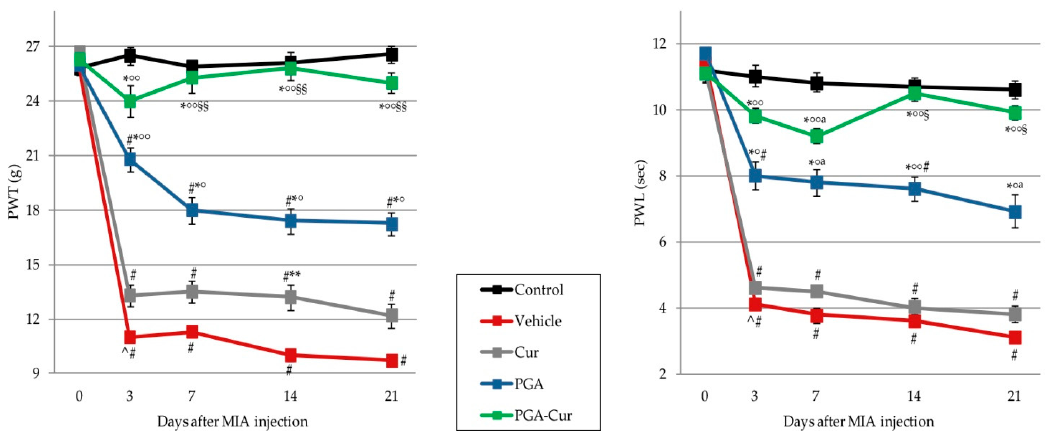
Figure 3. Effect of PGA and curcumin (Cur) given individually or in a co-micronized formulation (PGA-Cur) on monoiodoacetate-induced neuropathic pain. The effect was assessed on secondary allodynia by measuring paw withdrawal threshold (PTW) and paw withdrawal latency (PWL) before and after 3, 7, 14, and 21 days from MIA knee injection. Data are expressed as mean ± standard error of the mean (N = 10/group). PGA = micronized palmitoyl-glucosamine. ^ p < 0.0001 vs. previous time point; # p < 0.0001 and a p < 0.05 vs. control; * p < 0.0001 and ** p = 0.0295 vs. vehicle; ° p < 0.05 and °° p < 0.0001 vs. Cur; §§ p < 0.0001, § p < 0.005 vs. PGA.